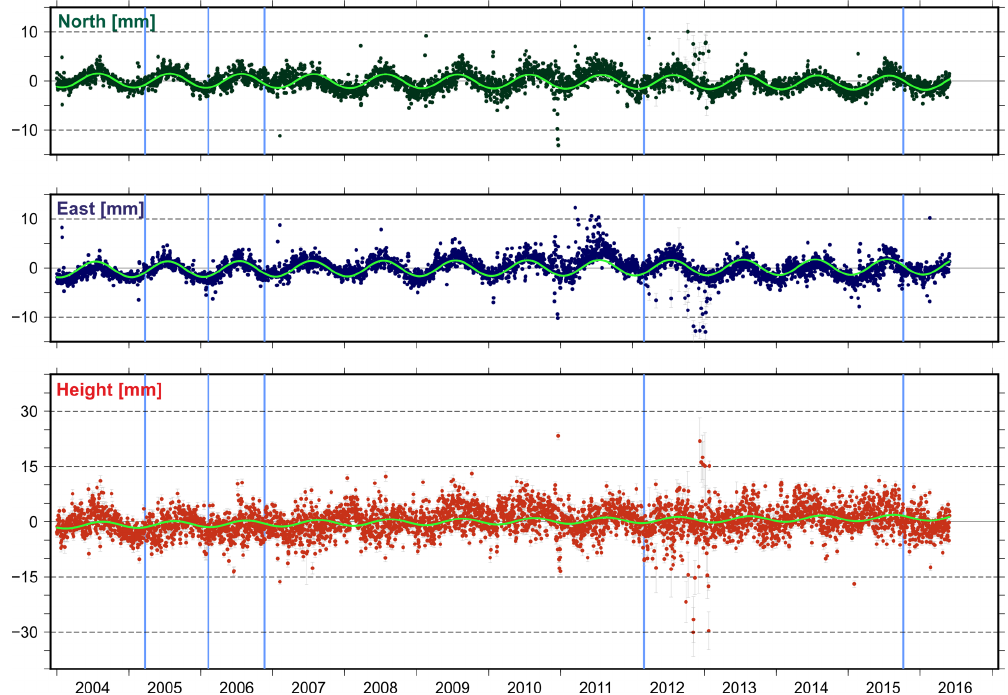
Figure 5. Position time series of the station KARL located in Karlsruhe, Germany. Annual signals are well observed in the north and east components. Equipment changes (indicated by the blue vertical lines) do not seem to affect the time